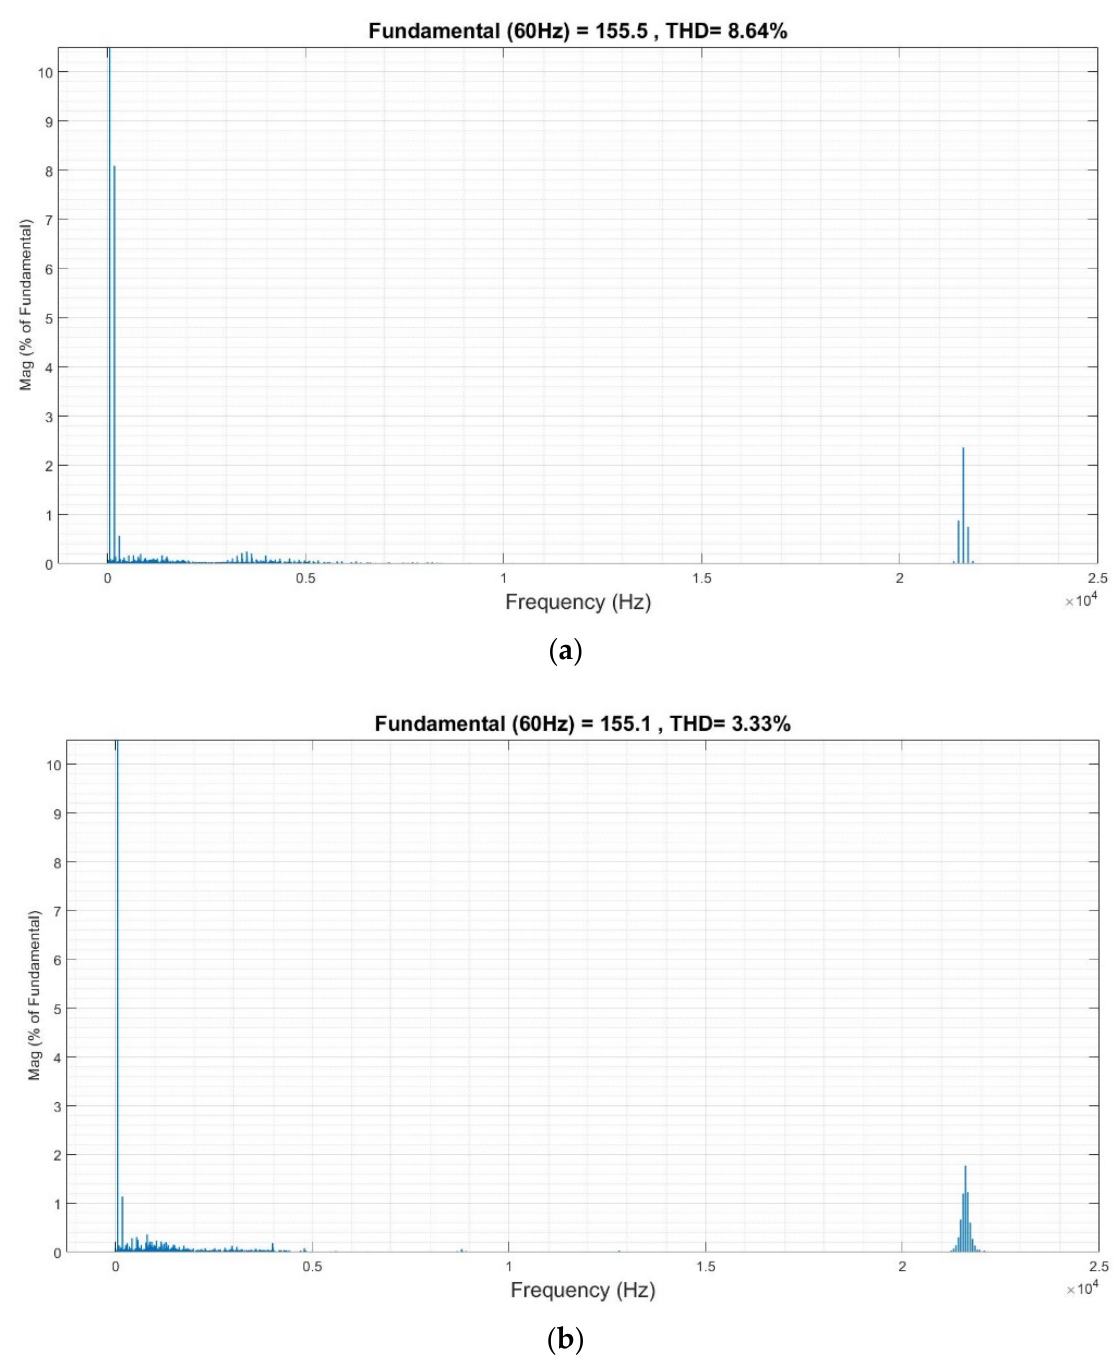
Figure 22. THD analysis of the simulation (500 W) when using ( a ) the traditional SPWM control and ( b ) modified SPWM control.